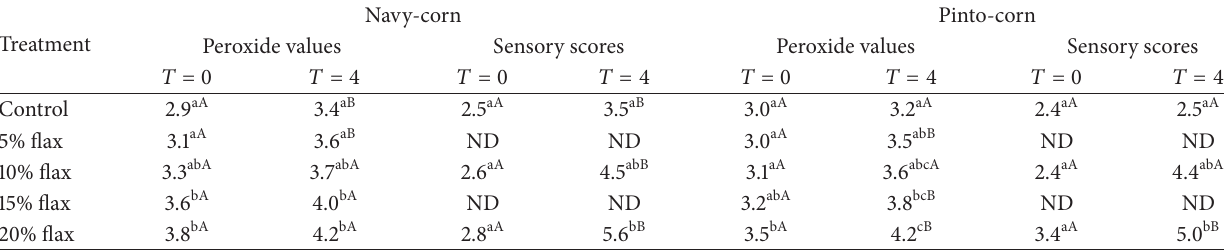
Table 5: Peroxide values and rancidity scores of navy-corn and pinto-corn extrudates at different time periods. Treatment